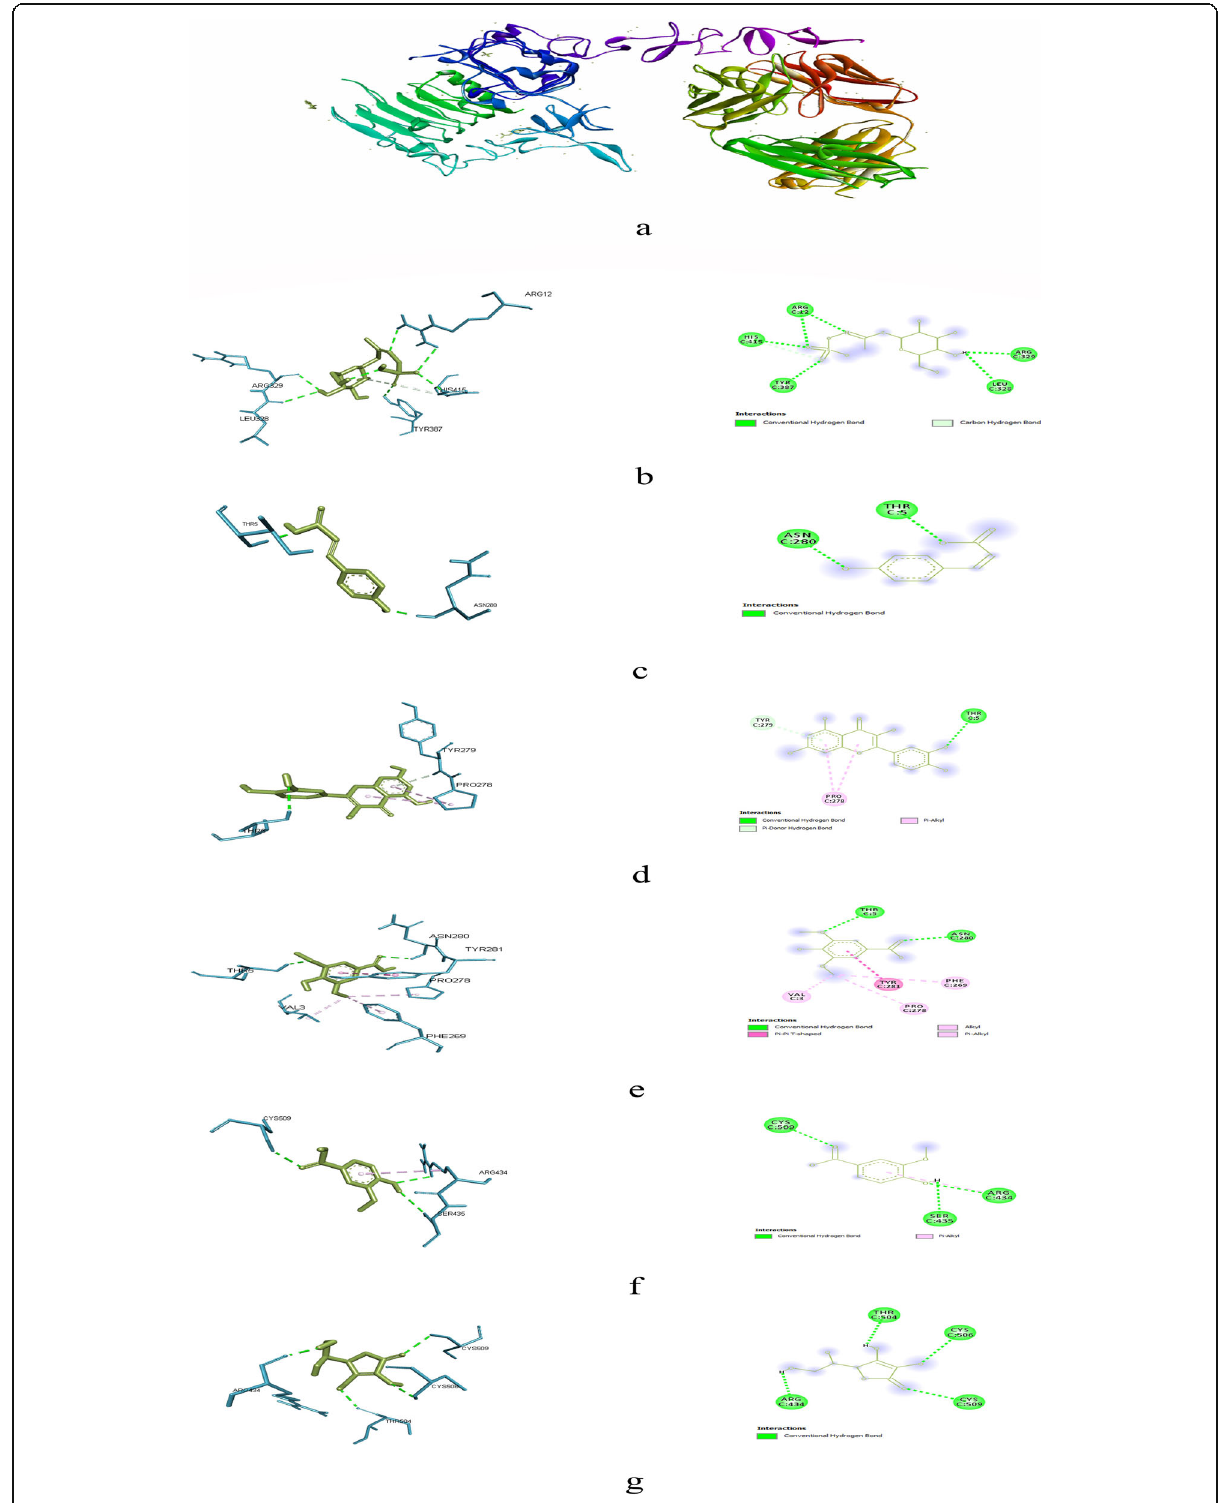
Fig. 6 a Crystal structure of extracellular domain of human HER2 (PDB id.: 1N8Z); Molecular interactions of the 2D and 3D confirmations of selected ligands showing significant binding affinity and hydrogen bond interactions ( ≥ 2). b Glucocapparin, c p-Coumaric acid, d quercetin, e syringic acid, f vanillic acid, g 5-FU complexed with Herceptin